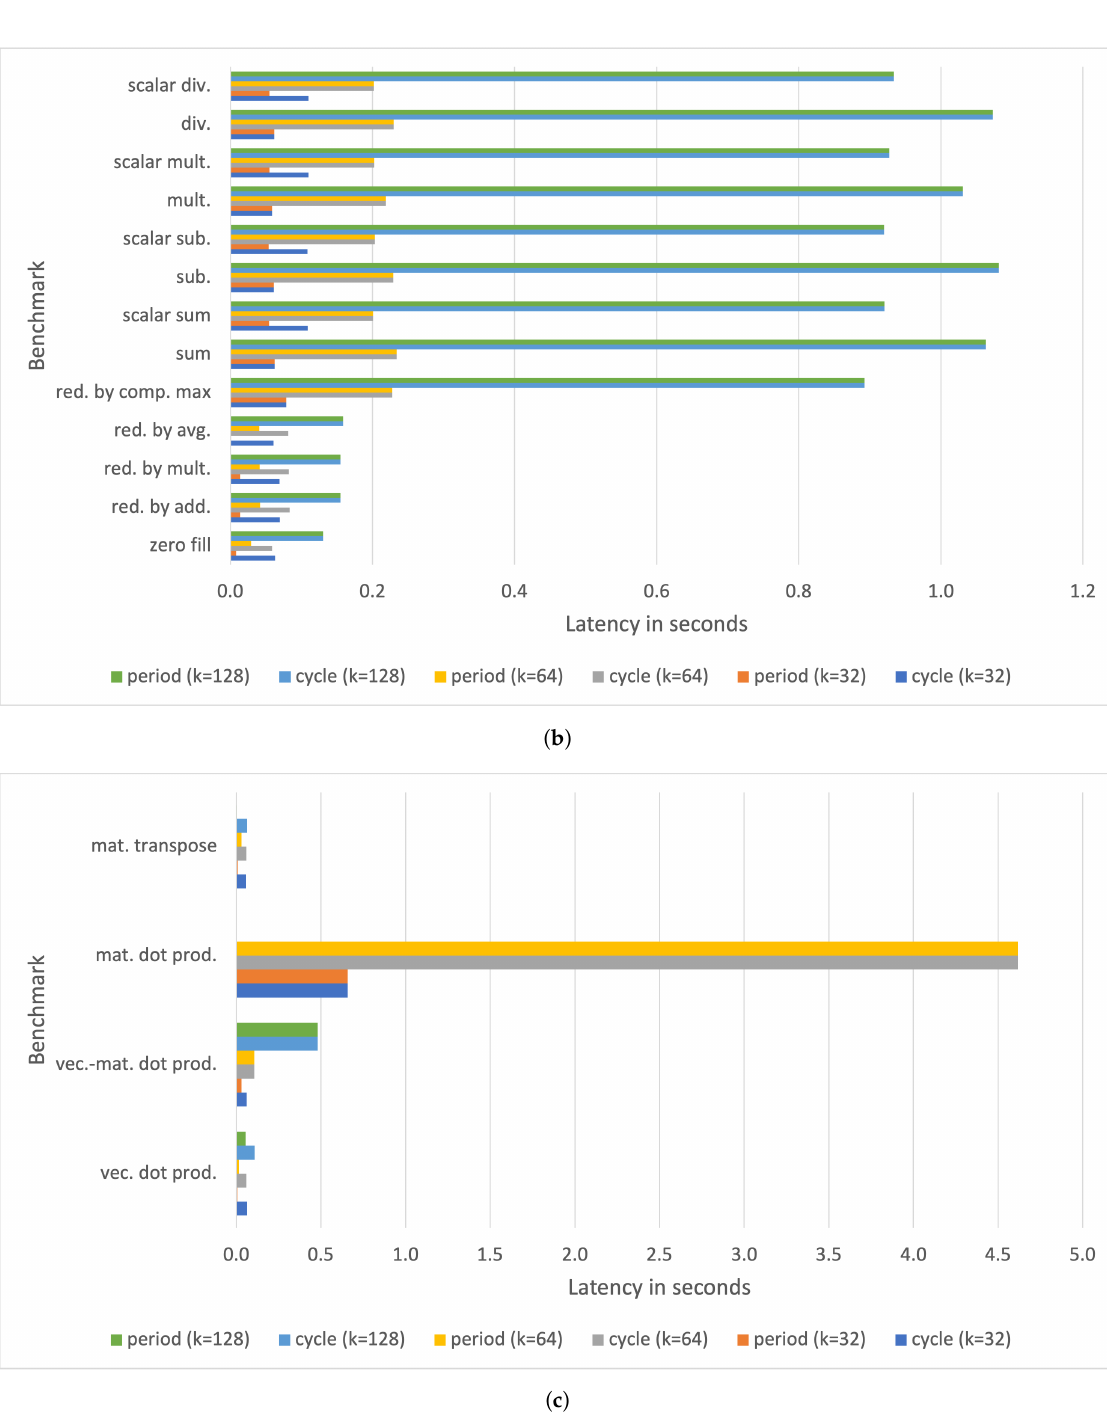
Figure 9. Measured period and cycle parameters with k ∈ { 32,64,128 } on a Raspberry Pi III B+ for ( a ) rank 1 tensor operations, ( b ) rank 2 tensor operations, and ( c ) typical vector and matrix